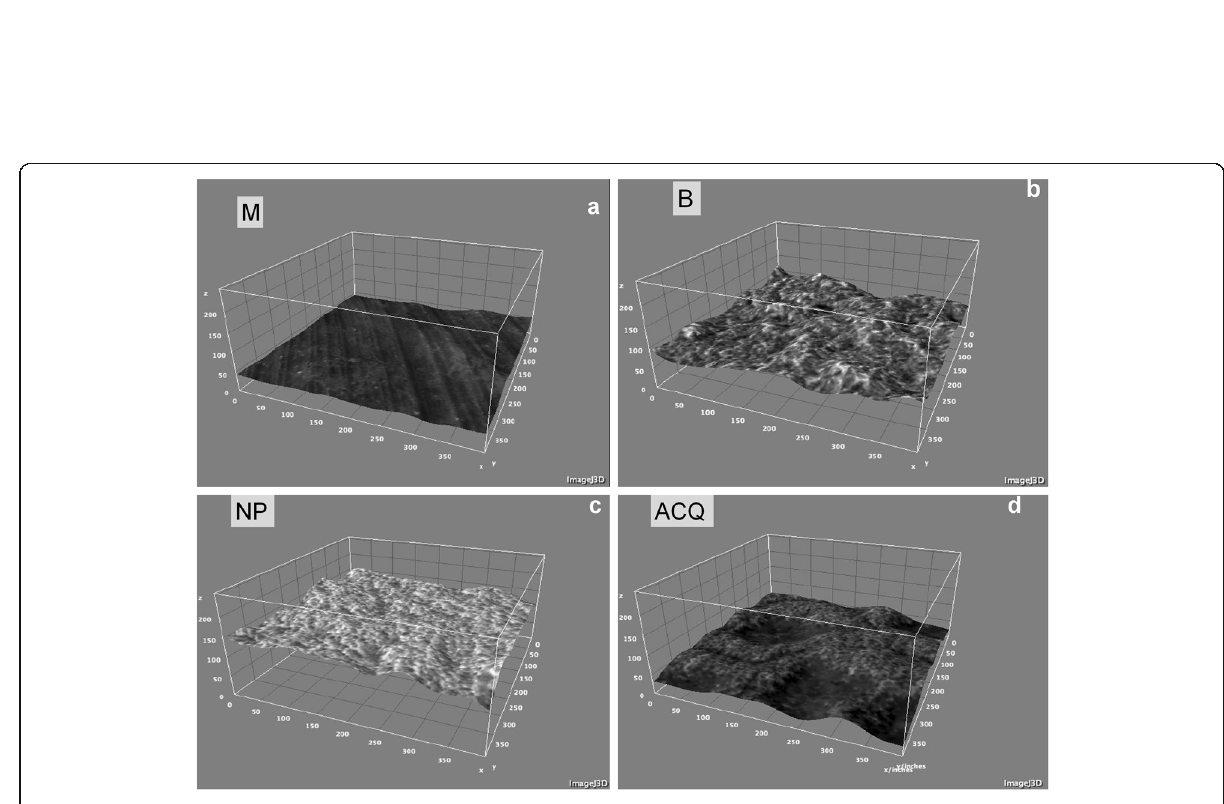
Fig. 2 3D surface plot. a M, b B, c NP, and d ACQ groups obtained by Interactive 3D, Surface Plot plugin (ImageJ, NIH,